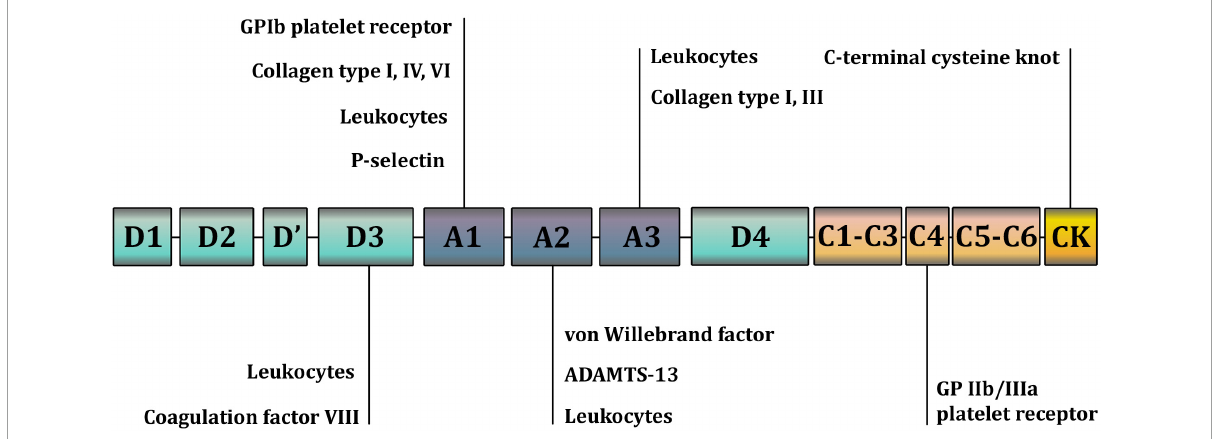
FIGURE1 A schematic representation of the domains and binding sites of the Von Willebrand factor (VWF) monomer. The A1 domain contains a binding site for the glycoprotein complex Ib/IX/V (GP Ib) of platelets; collagen types I, IV, VI; and heparin. The A2 domain contains binding sites for the ADAMTS-13 (a disintegrin and metalloproteinase with a thrombospondin type 1 motif 13) metalloprotease and VWF molecules. The A3 domain contains binding sites for collagen types I and III. The C4 domain contains a binding site for the platelet integrin α IIb β 3 (GPIIb/IIIa). C domains facilitate VWF flexibility. The D’D3 domain contains a binding site for coagulation factor VIII. The C-terminal cysteine knot (CTCK) is involved in the dimerization of VWF. All D domains are involved in the formation of disulfide bonds between VWF